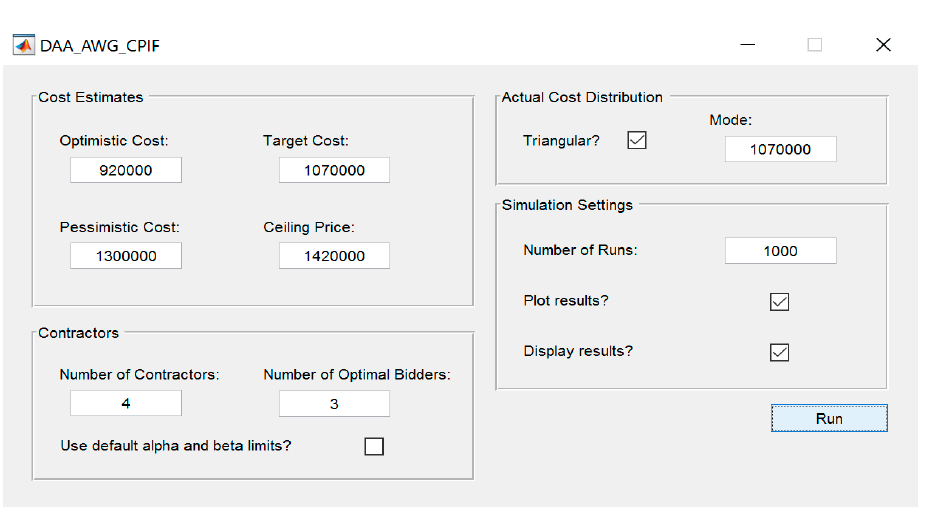
Figure 10. DAA-AWGE CPIF Optimal Bidder ∝ (cid:3036) and (cid:2010) (cid:3036) Limits